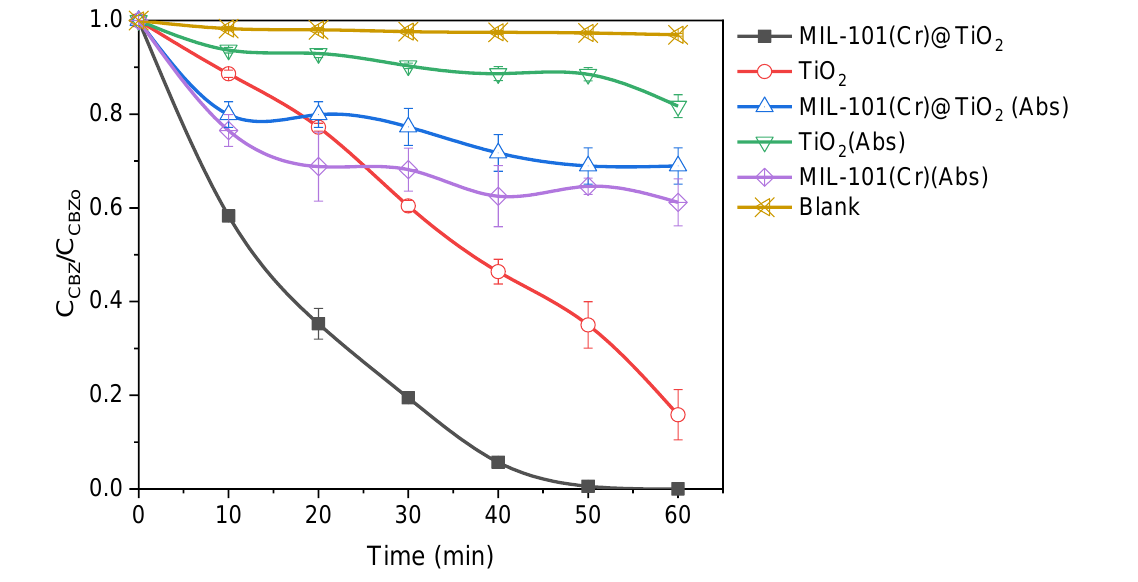
Figure 5. CBZ photocatalytic degradation and adsorption of different samples (2 g/L dosage, 12 mg/L of CBZ, and UV-A irradiation at 35 – 38 mW/cm 2 with a reaction time of 60 min).